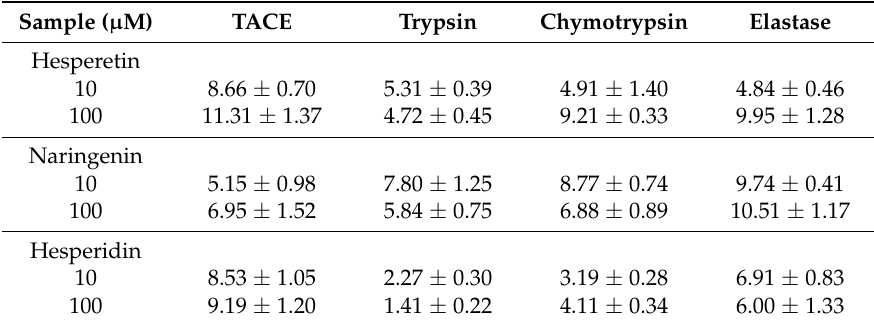
Table 2. Inhibitory activities (%) 1 of hesperetin, naringenin, and hesperidin against α-secretase (tumor necrosis factor-α converting enzyme, TACE) and other serine proteases.